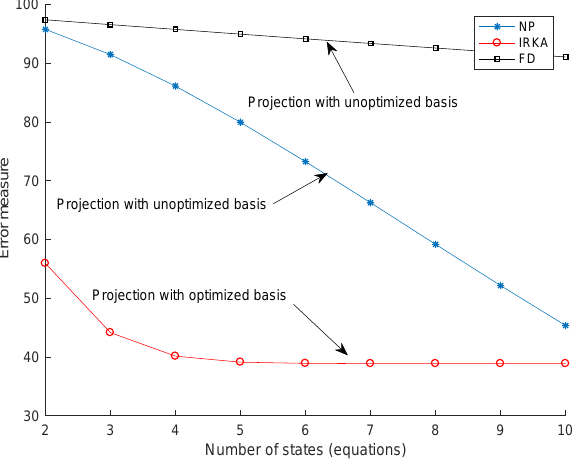
Figure 8. Convergence comparison of different methods.